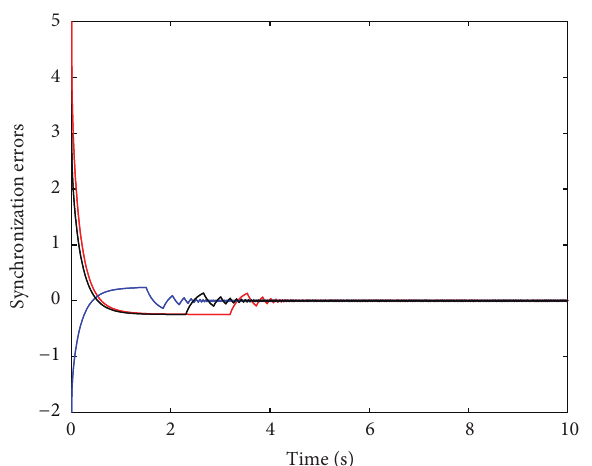
Figure 4: Synchronization errors states with 𝛼 = 0.5 (red line represents the first error state 𝑒 1 , blue line represents the second error state 𝑒 2 , and black line represents the third error state 𝑒 3 ).